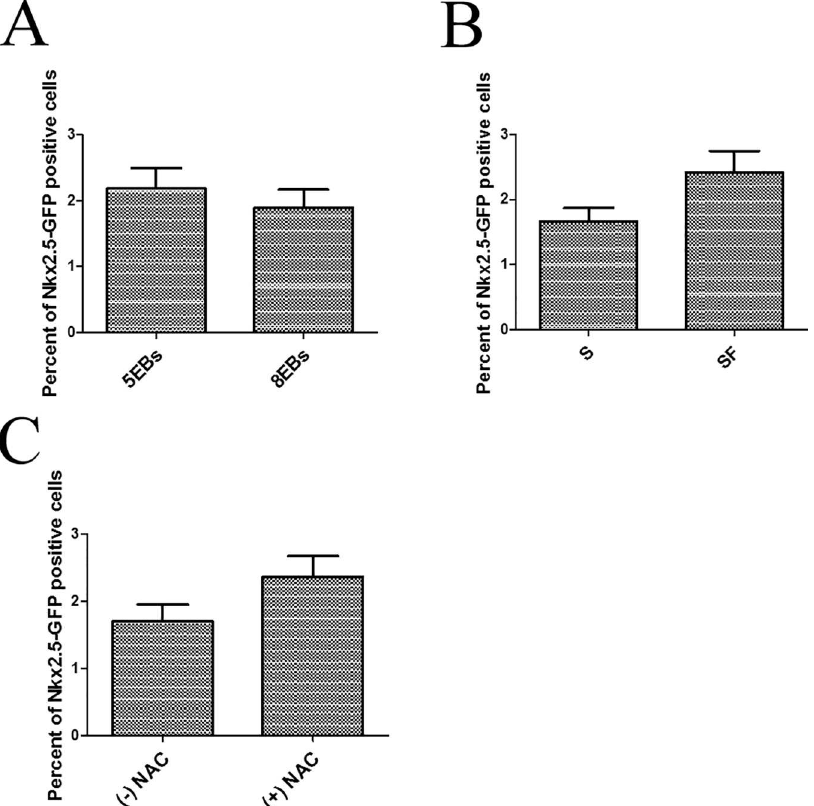
Fig 7. Flow-cytometric analysis of the Nkx2.5-GFP positive cell ratio in cells cultured as described in Fig 6A. Samples were analyzedat the end of the differentiationexperiment (8 days). Data are presented as the effect of individual variables: the adhesionof EBs on days 5 or 8 of differentiation (A), the presence (S) or absence(SF) of FBS (B), and the presence((+)NAC) or absence((-)NAC) of N-Acetyl Cysteine(C). Data are expressedas mean ± SEM (n = 4). Differences betweensamples were analyzedby Kruskal-Wallis test and post-hoc Dunns test and considered statistically significantfor p (cid:20) 0.05.